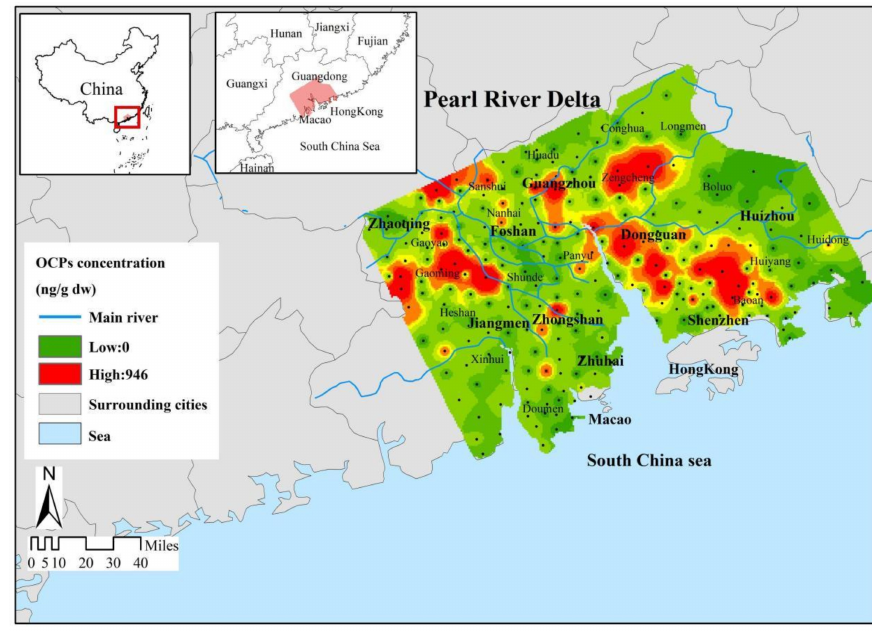
Figure 1. Spatial distribution of residual OCP concentration in agricultural soil in the